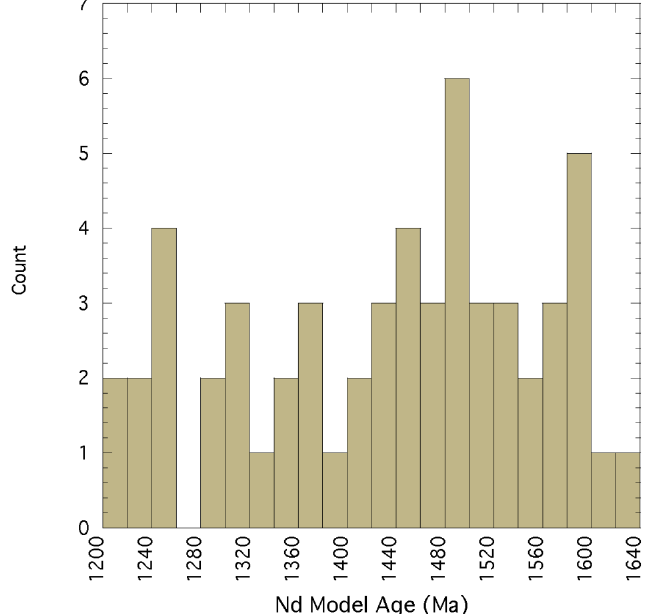
Figure 19. Nd model ages of greenstones in the eastern Grenville orogen, Canada. Data from Dickin [34], Dickin et al. [25] and McNutt and Dickin